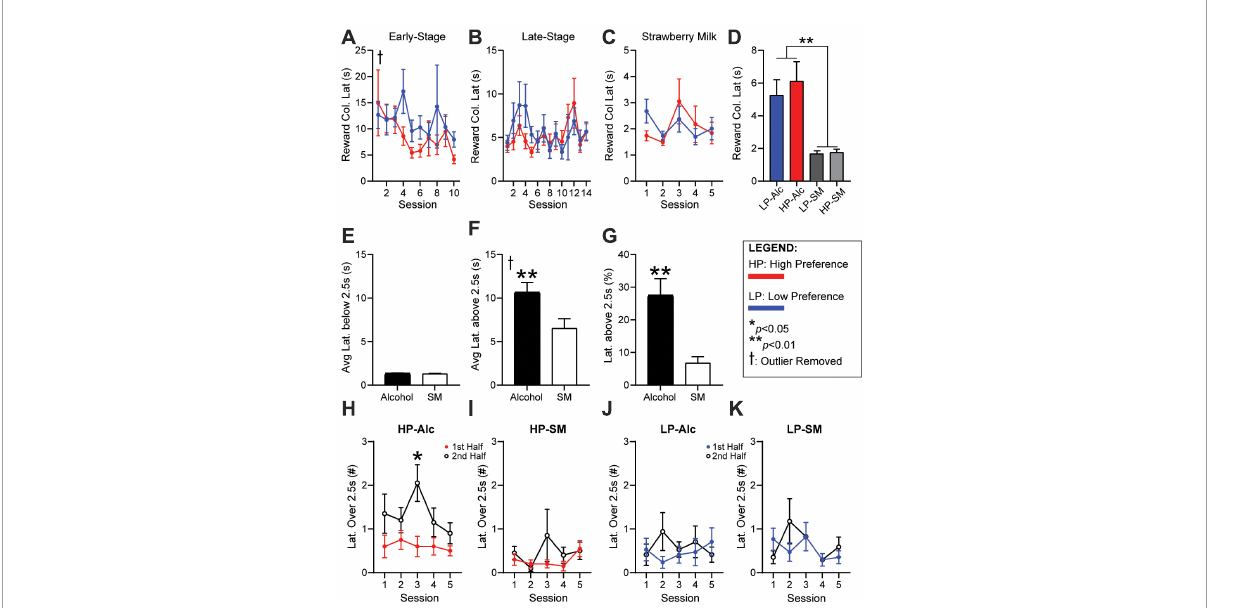
FIGURE3 Reward latencies are longer during the second half of HP sessions for alcohol, not SM. No differences in (A) early-stage, (B) late-stage, or (C) SM reward latency. (D) Average reward latency was greater for alcohol (HP/LP) compared to SM sessions (HP-SM/LP-SM). (E) Average latencies below 2.5 s were similar for alcohol and SM. (F) Average latency above 2.5 s were significantly greater during alcohol sessions. (G) The percentage of latencies greater than 2.5 s were much higher during alcohol sessions. HP reward latencies over 2.5 s occurred significantly more during the second half of (H) alcohol, but not (I) SM sessions. LP reward latencies were similar between the first and second half during (J) alcohol and (K) SM sessions. The number of trials per session half is 14 for HP-Alc, 35 for HP-SM, 13 for LP-Alc, and 32 for LP-SM. n = 24 for panel (A–D) , n = 48 for panel (E–G) , n = 17–21/group for panel (H–K) . * p < 0.05, ** p < 0.01 for group effect. All data are expressed as ± standard error mean. † removed one outlier (over 200